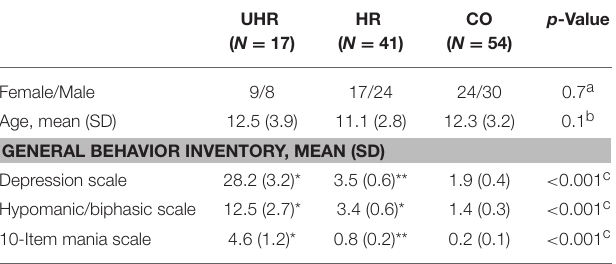
TABLE 2 | Demographic and clinical variables of the UHR and HR subgroups and the CO